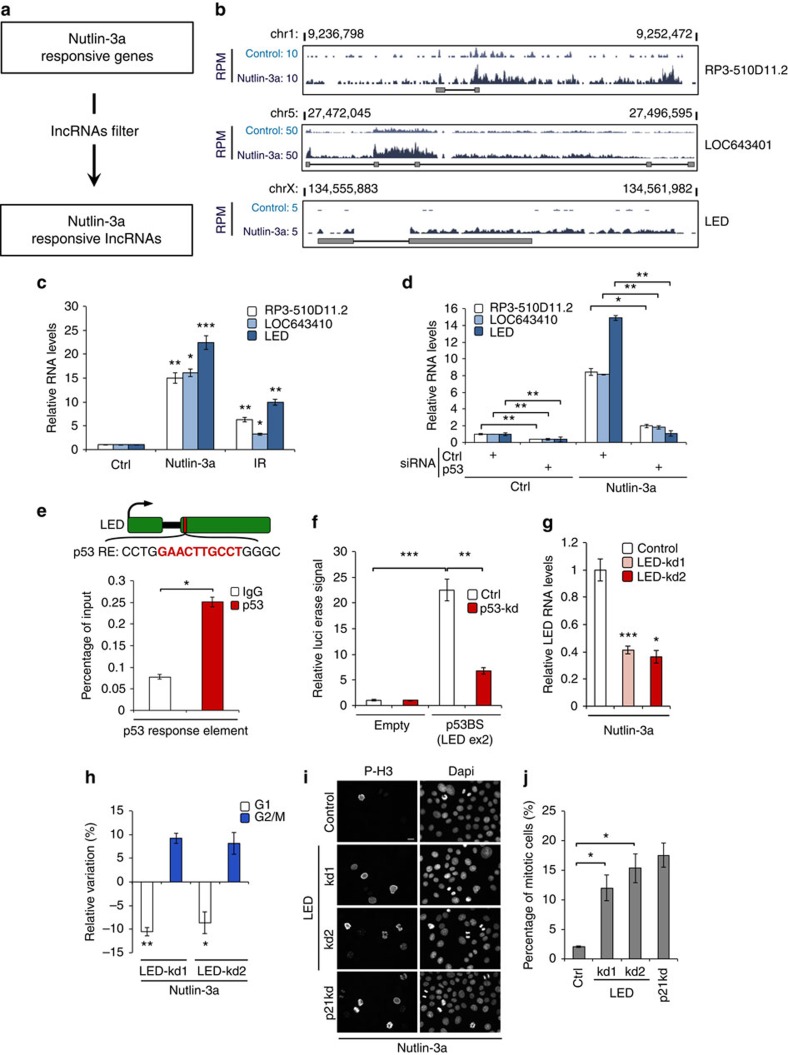
Novel p53-regulated lncRNA LED.(a) Outline of pipeline for identification of p53-regulated lncRNAs. MCF-7 cells were treated with 8 μM nutlin-3a for 12 h and subjected to RNA sequencing (RNA-seq). (b) Display of genomic location and RNA-seq data showing the nutlin-3a induction of selected lncRNAs in MCF-7 cells. Values are represented by RPM (reads per million). (c) Stress-dependent regulation of selected lncRNAs upon nutlin-3a (8 μM) and ionizing radiation (IR; 10 Gy) treatment in MCF-7 cells measured by quantitative reverse transcription–PCR (qRT–PCR). Values are represented by fold induction (n=3; ***P<0.005, **P<0.01, *P<0.05, two-tailed Student’s t-test). (d) P53-dependent regulation of validated lncRNAs in MCF-7 cells transfected with a control (Ctrl) or p53 siRNA in the presence or absence of nutlin-3a. Values are represented by fold induction (n=3; **P<0.01, *P<0.05, two-tailed Student’s t-test). (e) Schematic representation of p53 response element (p53 RE) in LED gene body. Chromatin immunoprecipitation performed in nutlin-3a-treated MCF-7 cells using IgG or p53 antibodies followed by qPCR in the p53 RE region. Values represent the percentage of input (n=3; *P<0.05, two-tailed Student’s t-test). (f) MCF-7 cells were co-transfected with an empty or LED (exon 2) p53BS pGL3-basic vector and either a Ctrl or p53-targeting siRNA. The relative luciferase activities (Firefly/Renilla) were normalized to the Ctrl reaction (empty pGL3-basic vector; n=3; ***P<0.005, **P<0.01, two-tailed Student’s t-test). (g) qRT–PCR measuring relative LED RNA levels in MCF-7 cells transfected with a Ctrl or two independent LED siRNAs (LED-kd; n=3; ***P<0.005, *P<0.05, two-tailed Student’s t-test). (h) Relative cell cycle variation (LED-kd minus control-kd) of MCF-7 cells transfected with a Ctrl or two independent LED siRNAs, treated with nutlin-3a for 12 h. To capture cycling cells in G2/M, cells were treated with nocodazole for 24 h, before flow cytometric analysis (n=3; **P<0.01, *P<0.05, two-tailed Student’s t-test). (i) Immunostaining detection of the mitotic marker phospho-histone H3 ser10 (P-H3) and 4,6-diamidino-2-phenylindole (DAPI) staining in MCF-7 cells treated as in h and using a siRNA targeting p21 (p21kd) as a positive Ctrl. Scale bar, 25 μM. (j) Quantification of the marker P-H3 from i indicating the percentage of mitotic cells (n=3; *P<0.05, two-tailed Student’s t-test).